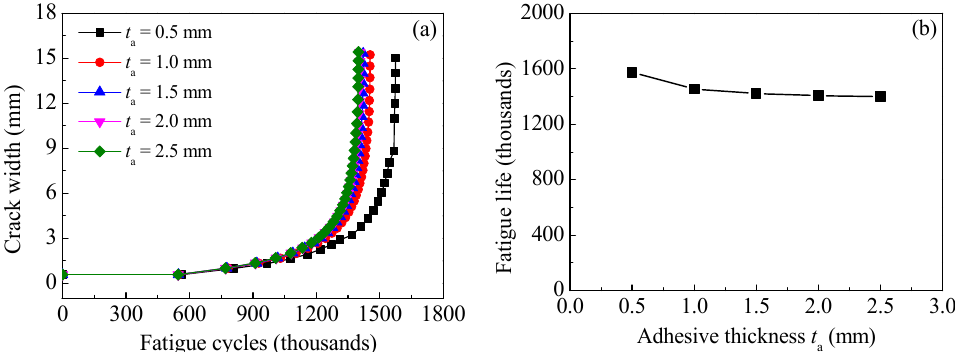
Figure 22. Effect of adhesive thickness on ( a ) the crack propagation curves and ( b ) the fatigue life of the corroded steel plate strengthened with CFRP plates.